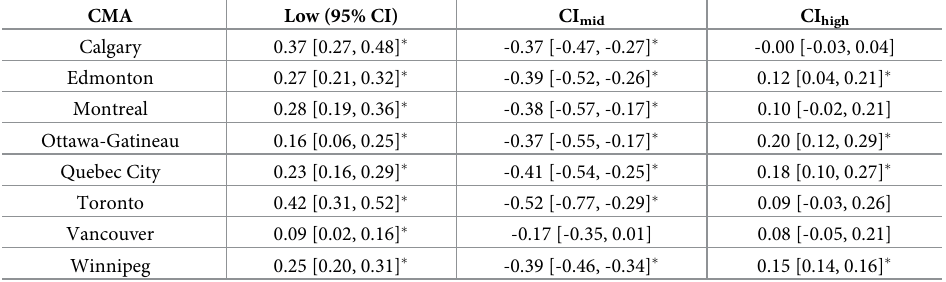
Table 1. Slopes of the three income groups (low, middle & high) and their associated 95% confidence intervals (CI) obtained via non-parametric bootstrapping of household income data. CMA